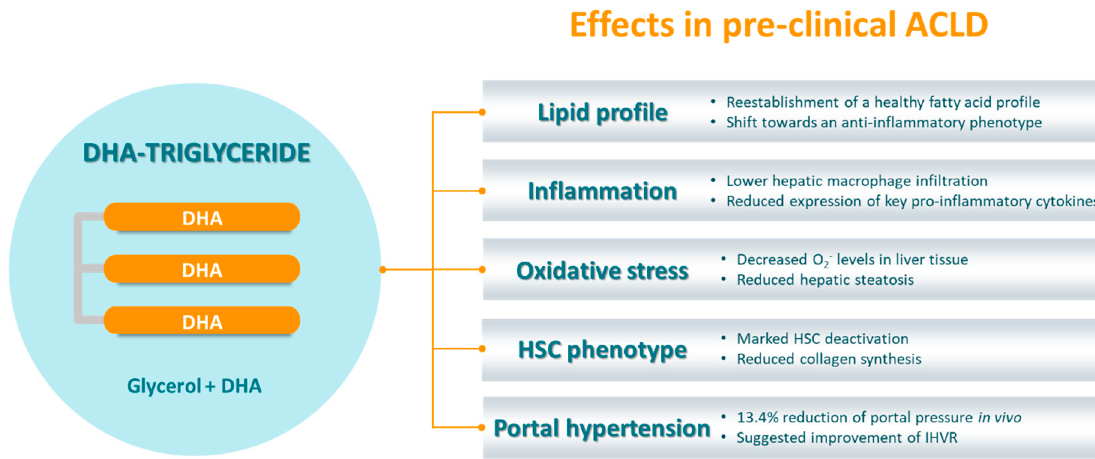
Figure 2. DHA triglyceride structure and demonstrated effects in an animal model of advanced chronic liver disease. Treatment with DHA triglycerides (TG-DHA) improved many aspects of ACLD pathophysiology in a rat model of the disease, including hepatic fatty acid profile, inflammation, oxidative stress, HSC phenotype and portal hypertension. ACLD, advanced chronic liver disease; DHA, docosahexaenoic acid; HSC, hepatic stellate cells; IHVR, intrahepatic vascular resistance; O 2 − , superoxide anion.